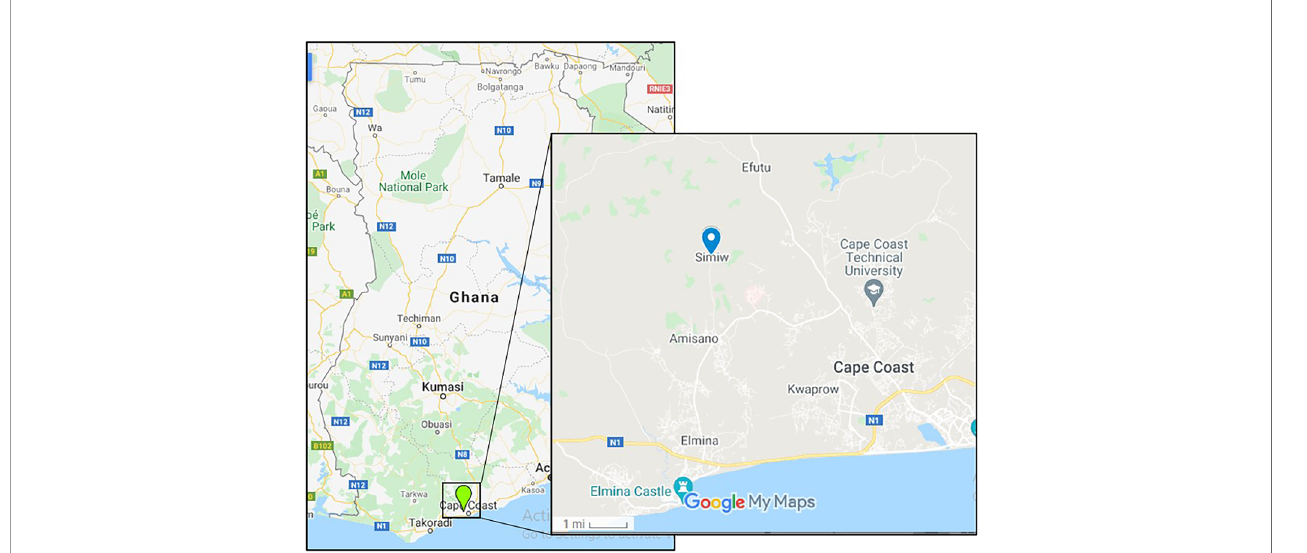
FIGURE 1 | A map of Ghana showing the study site (Simiw) in the enlarged area. The map was generated using Google